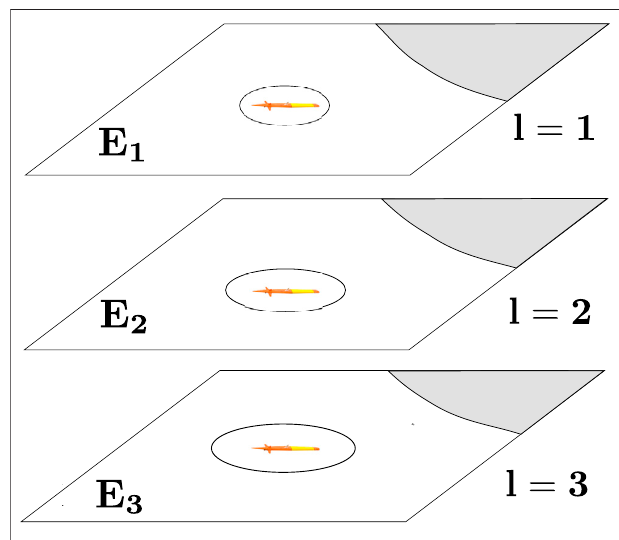
FIGURE 2 | Localization uncertainty of a vehicle increases as it goes down along different water current